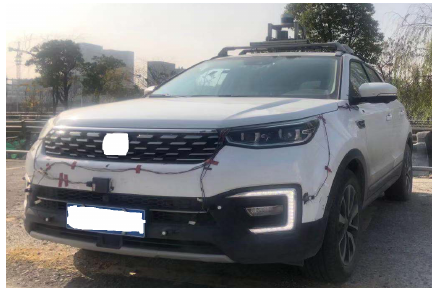
Figure 8. Test vehicle configuration.